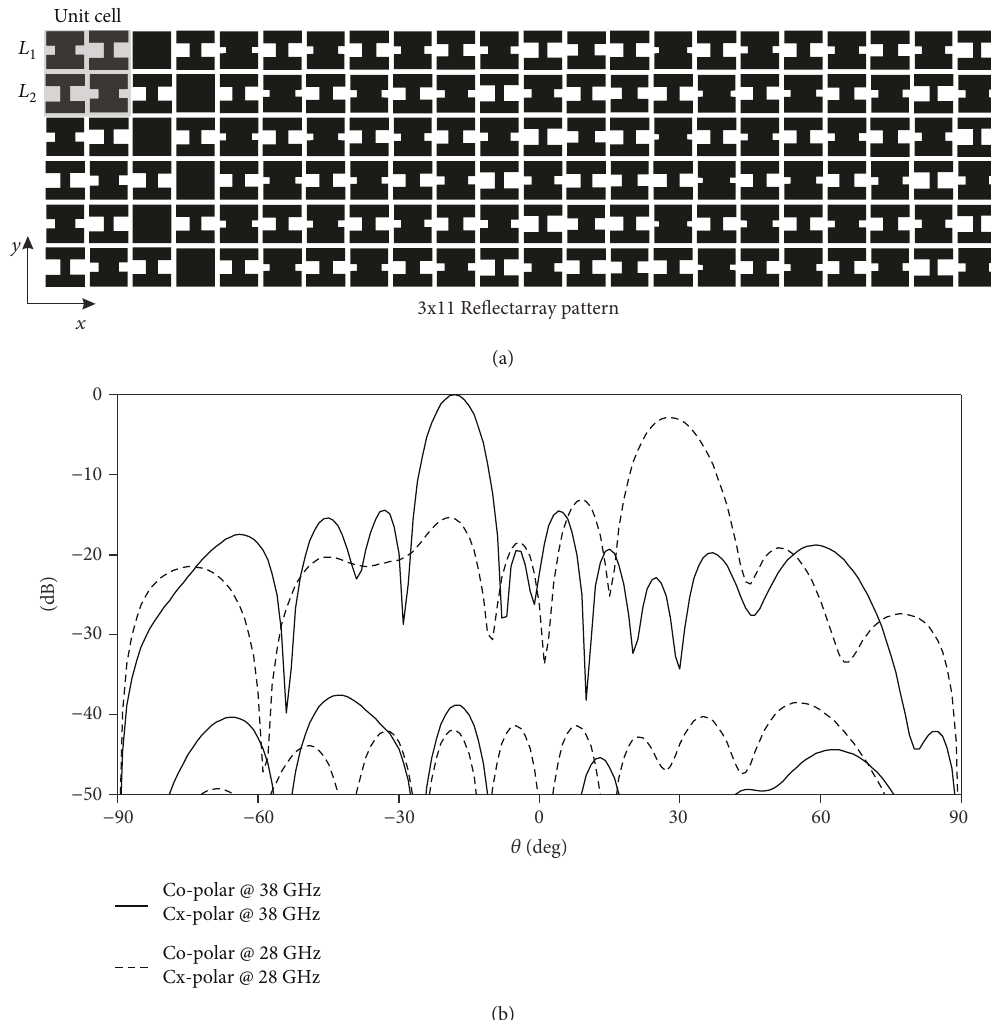
Figure 8: Synthesized dual-band scanned re fl ectarray: (a) re fl ectarray layout and (b) simulated radiation patterns at the designed